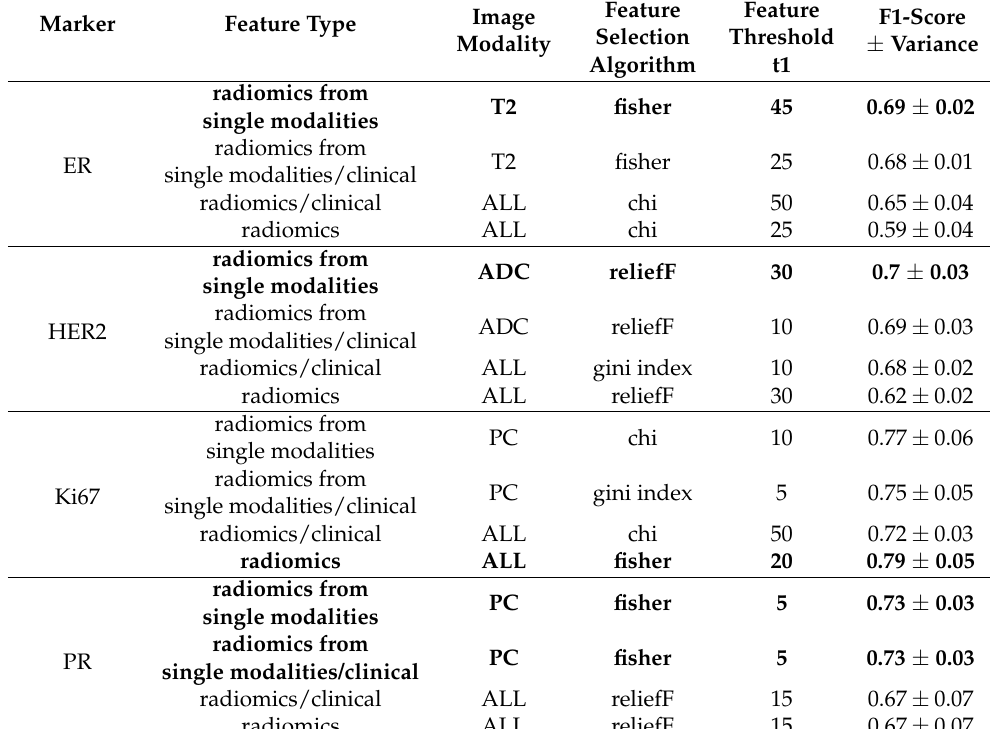
Table 4. Best results of the first feature selection step for all markers. For each combination of features (i.e., single radiomics, single radiomics with clinical information) and for each combination of modalities (i.e., all together (ALL) and single), the best mean F1-score obtained over the folds is shown. Bold font indicates the best results for each